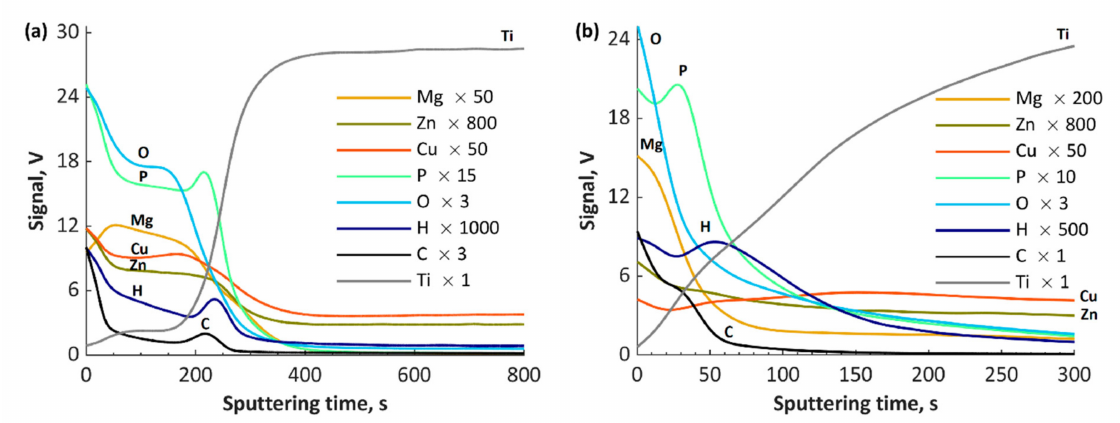
Figure 10. GDOES depth profiles of the coatings: ( a ) TiZnCuCa-35; and ( b ) TiZnCuCa-135.